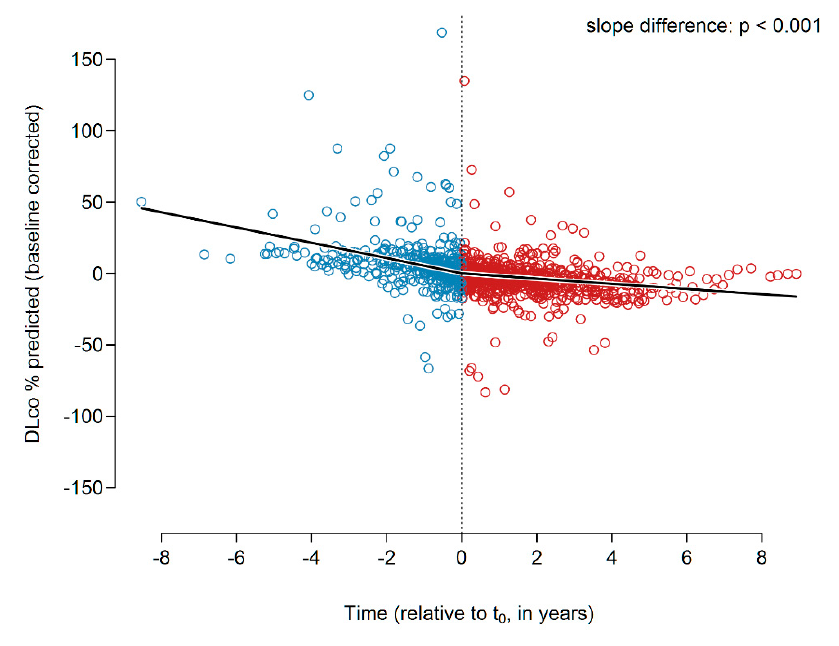
Figure 2. DLco slopes (% predicted) before and during pirfenidone treatment. Abbreviations: DLco—diffusion capacity of the lungs for carbon monoxide.